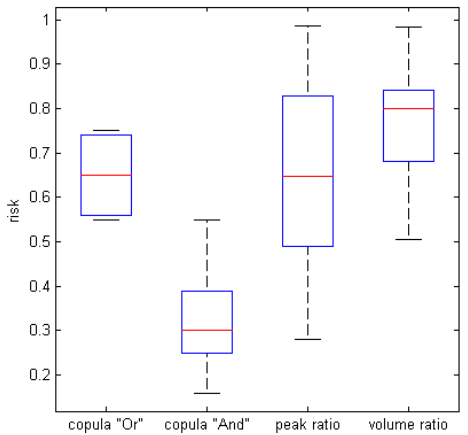
Figure 15. Risk comparison among four scenarios.